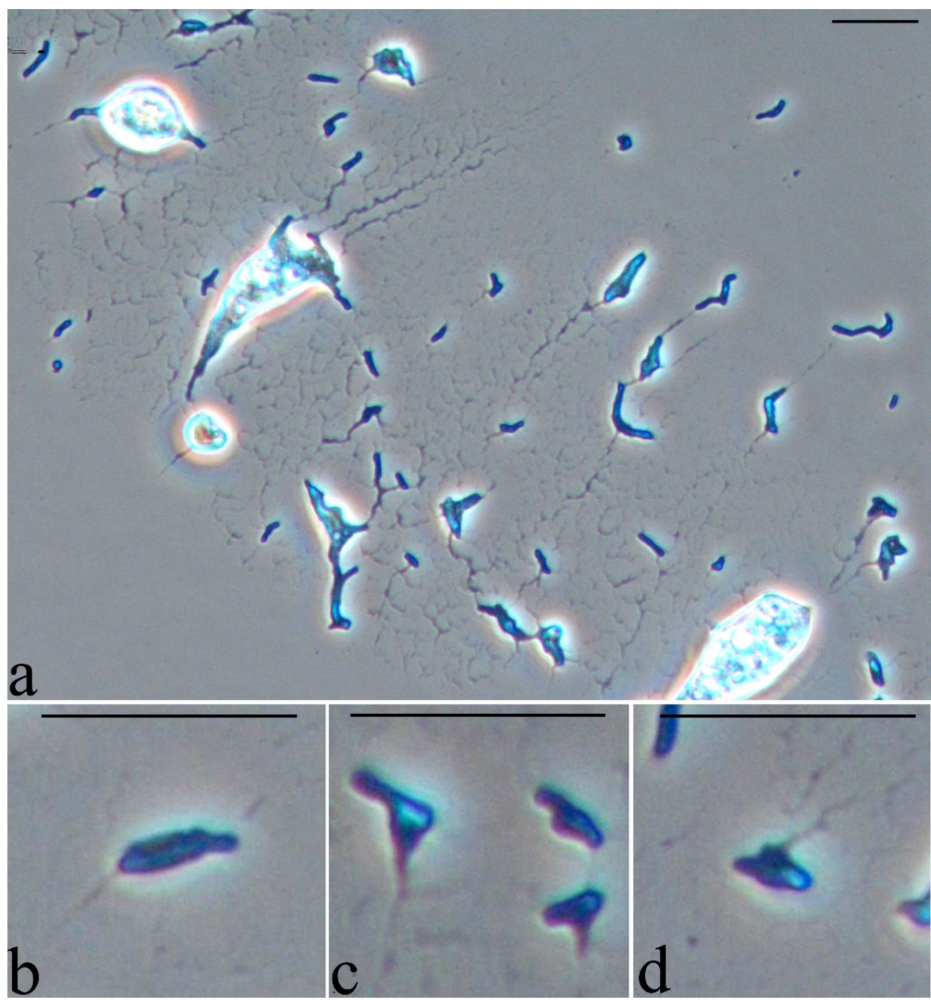
Figure 7. Strain S8 on hexadecane 4 days of growth. Light microscopy, phase contrast. The length of the scale bar is 10 µ m. Bacterial cells are “pushed out” from the growth medium on hexadecane during preparation for light microscopy (applying the surface foam material, where the microbial utilization of hexadecane occurs, on a glass slide and pressing the drop with a cover slip) ( a ). Various forms of some cells with substrate residues on their surface ( b – d